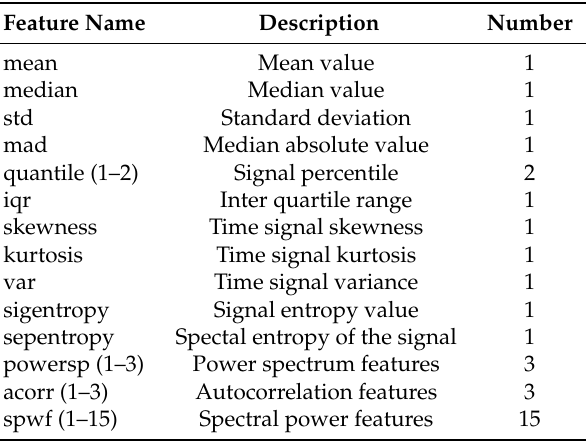
Table 4. List of feature vectors.